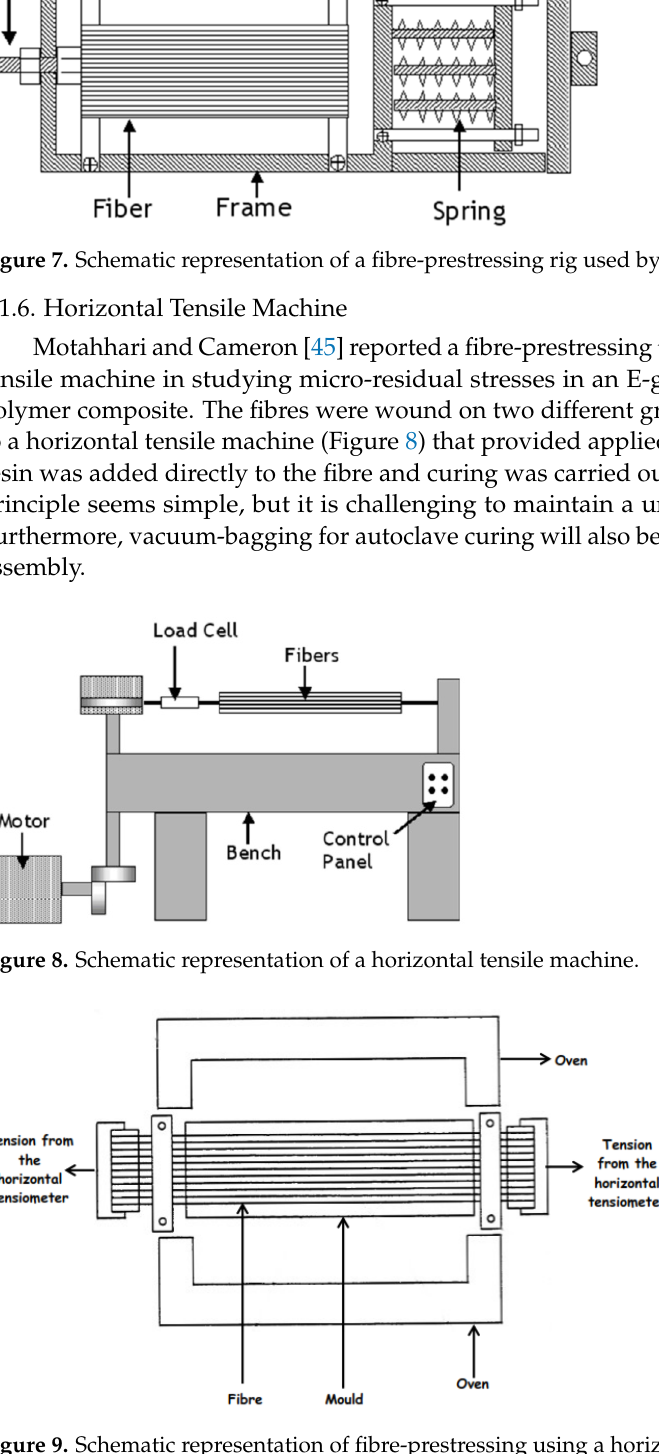
Figure 9. Schematic representation of fibre-prestressing using a horizontal tensile machine.